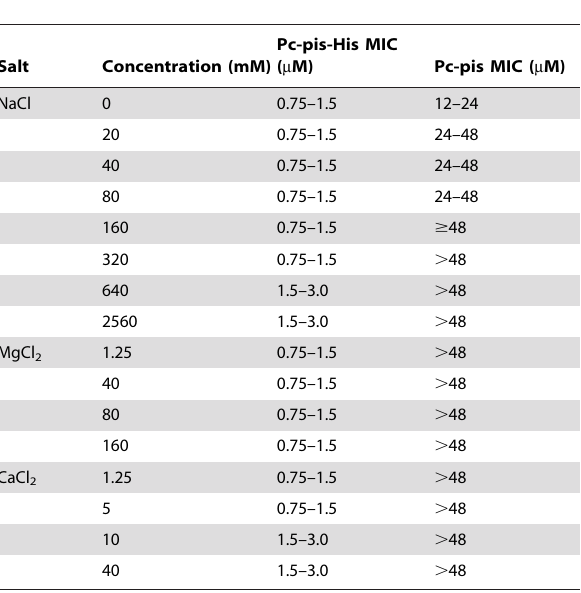
Table 2. Effect of monovalent and divalent cations on activity of Pc-pis-His and Pc-pis against S. aureus .